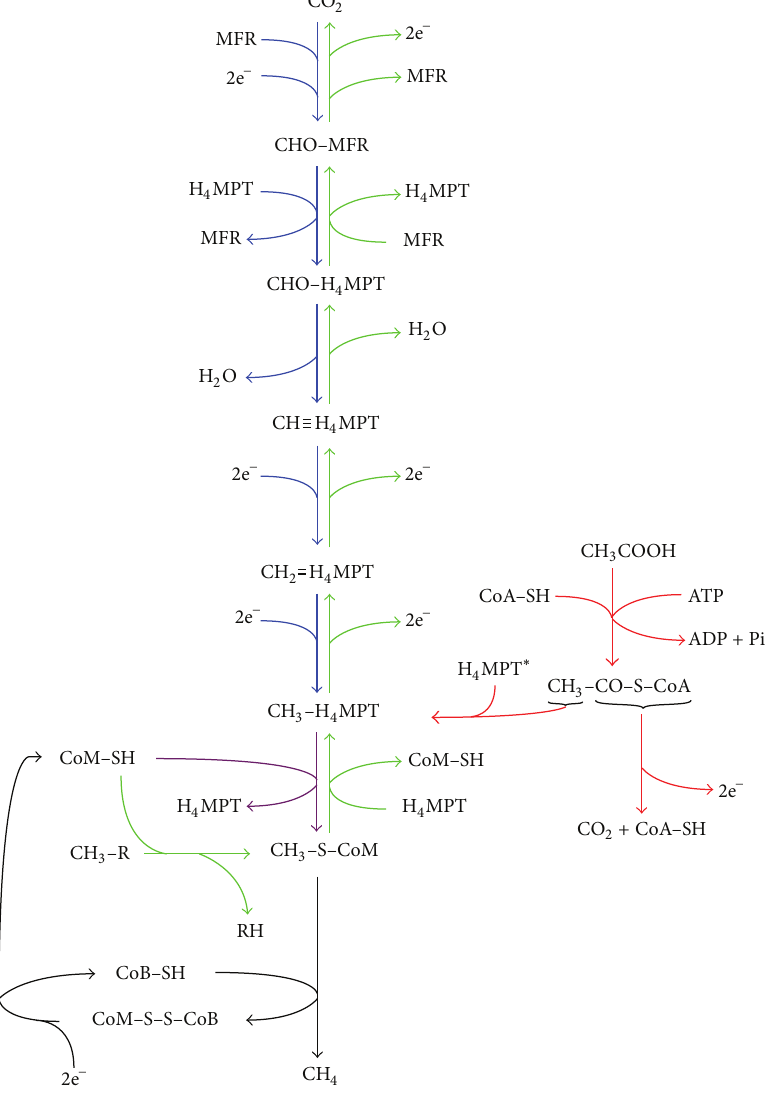
Figure 1: Overview of the three major known methanogenic pathways in Archaea. Color coding indicates the steps common to all three types (black), unique to the methylotrophic pathway (green), unique to the hydrogenotrophic (or CO 2 reducing) pathway (blue), unique to the aceticlastic pathway (red), and shared between hydrogenotrophic and aceticlastic methanogenesis (purple). 2e − represents reducing equivalents, produced or consumed during each reaction. MFR: methanofuran; H 4 MPT: tetrahydromethanopterin; CoM-SH: coenzyme M; CoB-SH: coenzyme B; CoA-SH: coenzyme A; CoM-S-S-CoB: heterodisulfide of coenzyme M and coenzyme B; ATP: adenosine triphosphate; R: ligand bound to methylated compound that serves as substrate for methylotrophic methanogenesis. ∗ Tetrahydrosarcinapterin is a functional analogue of H 4 MPT found in the Methanosarcinales order of